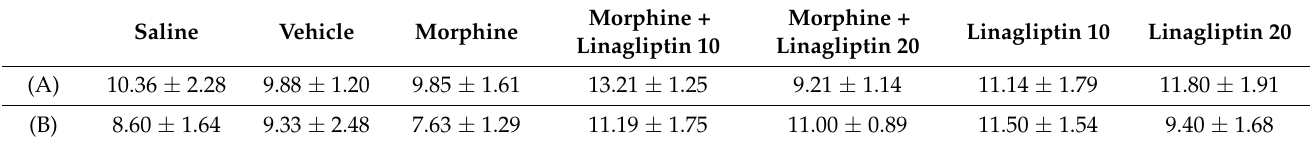
Table 1. The influence of linagliptin (10 and 20 mg/kg, ip) administered simultaneously with morphine on the locomotor activity of mice observed in the elevated plus maze test during: (A) short-term (60 h) and (B) long-term (14 days) morphine withdrawal.